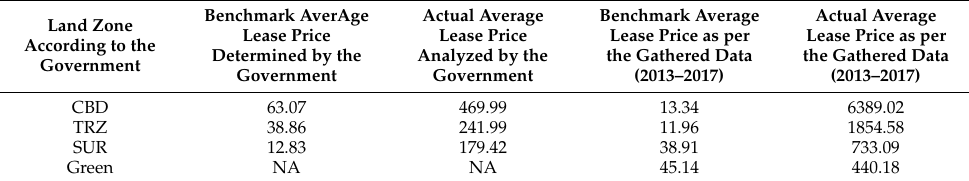
Table 3. Average benchmark price (in USD) per land zone.